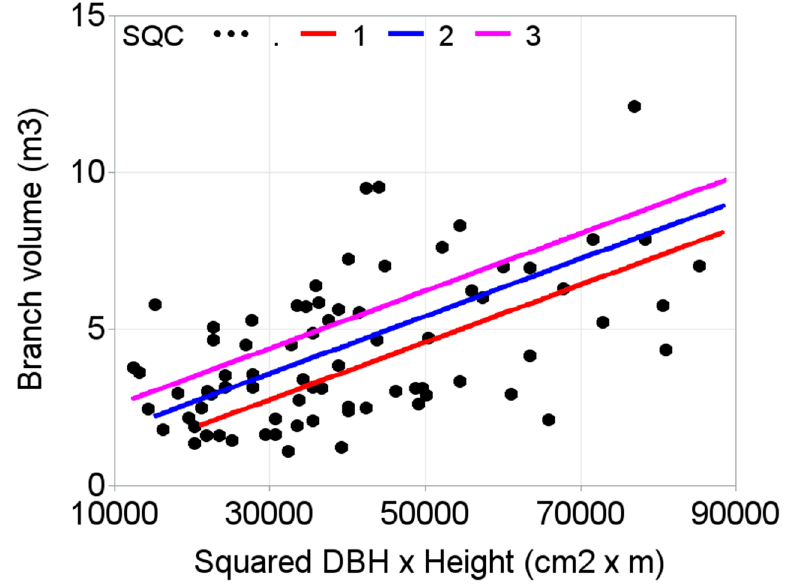
Figure 9. Simulated effects of site quality class (SQC) on the branch volumes. The branch volume curves were produced using parameter estimates of the branch volume prediction model (Equation (4)). Black dots represent the measured branch volumes. SQC = 1: rich; SQC = 2: medium; SQC = 3: poor.